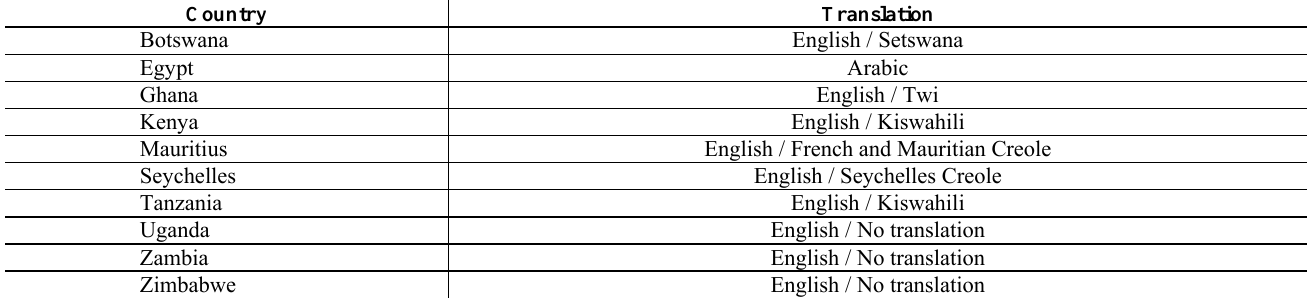
Table 4: Questionnaire translation by